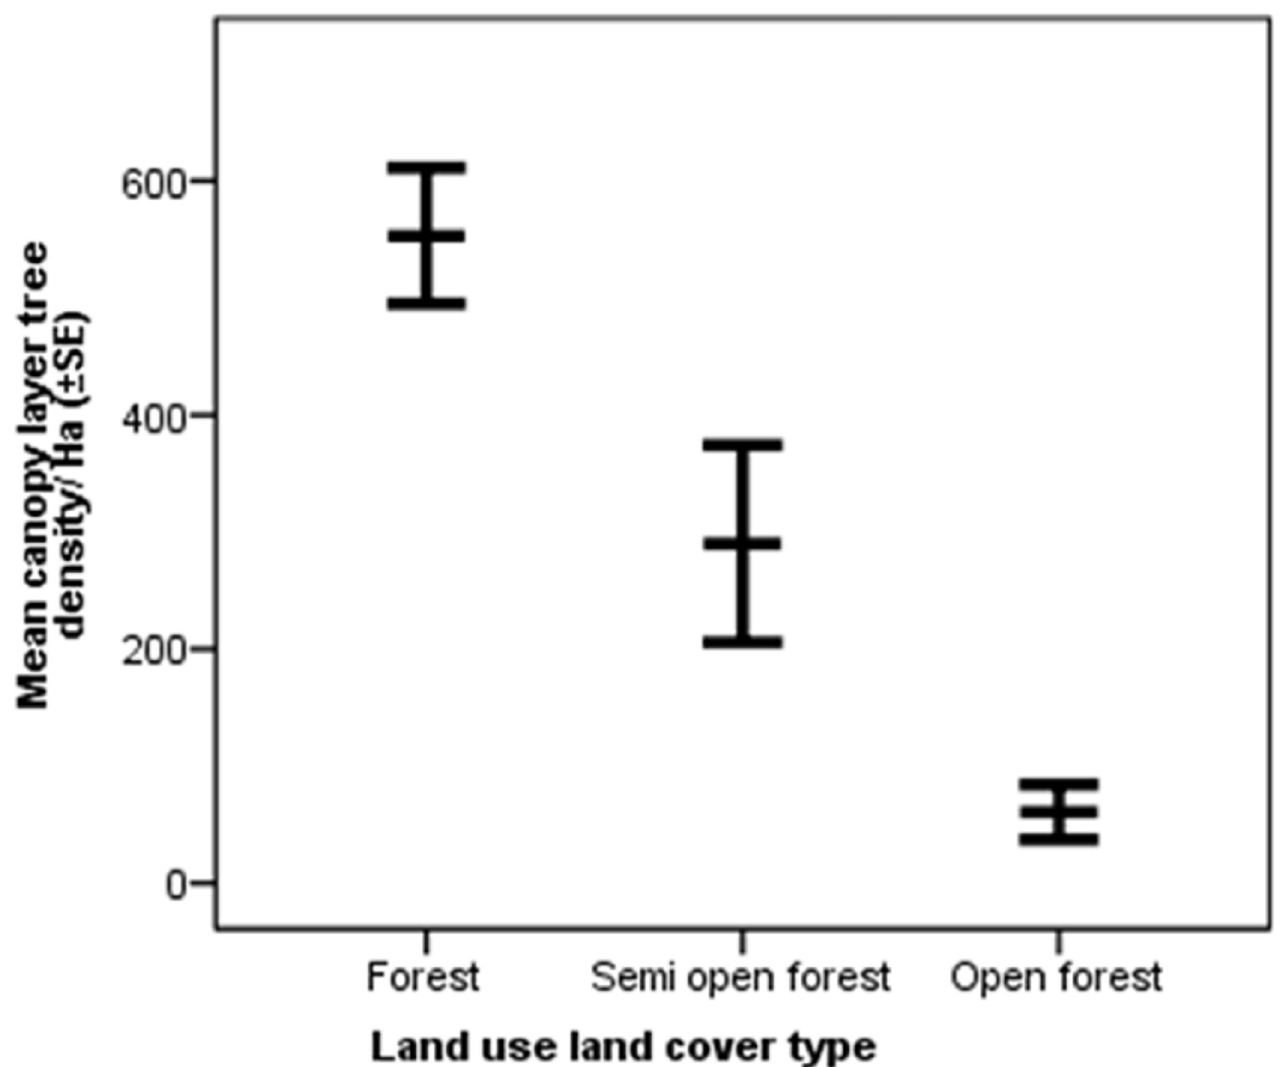
Fig 7. Mean ( ± SE) canopy layer tree density in the forest, semi-open forest, and open forest.